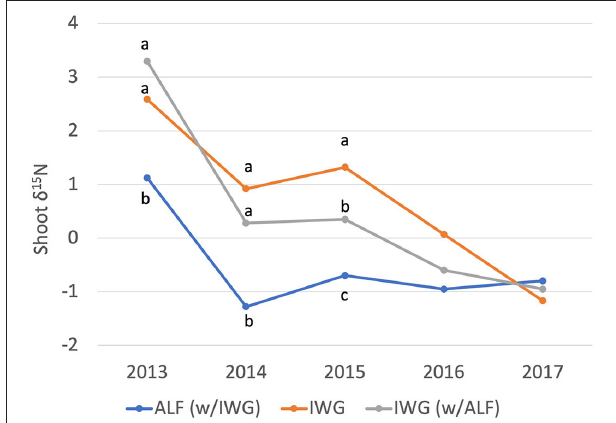
FIGURE 9 | Changes in shoot δ 15 N over 5 years from IWG-ALF and IWG treatments in the replacement intercrop design. Crop designations are ALF (w/IWG) = shoots from alfalfa grown with intermediate wheatgrass, IWG = shoots from intermediate wheatgrass grown in monocrop, IWG (w/ALF) = shoots from intermediate wheatgrass grown with alfalfa. Bars with different lowercase letters indicate significant differences at p < 0.05 (Tukey HSD).